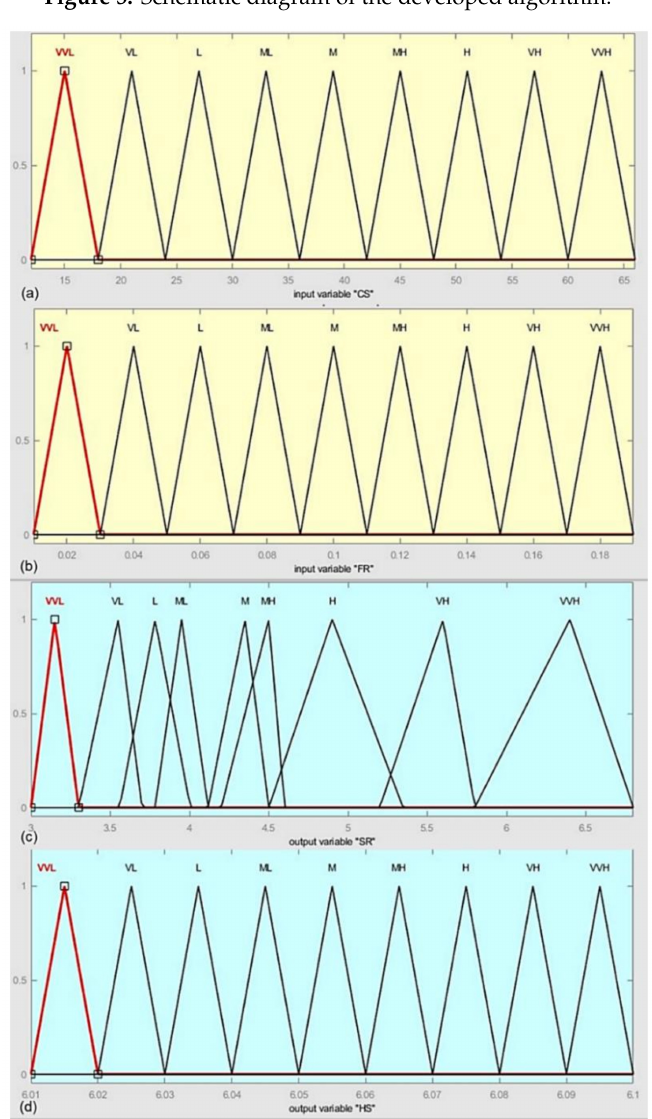
Figure6. Membershipfunctions: ( a )inputmembershipfunctionforcuttingspeed; ( b )inputmembership function for feed rate; ( c ) output membership function for surface roughness; ( d ) output membership function for hole